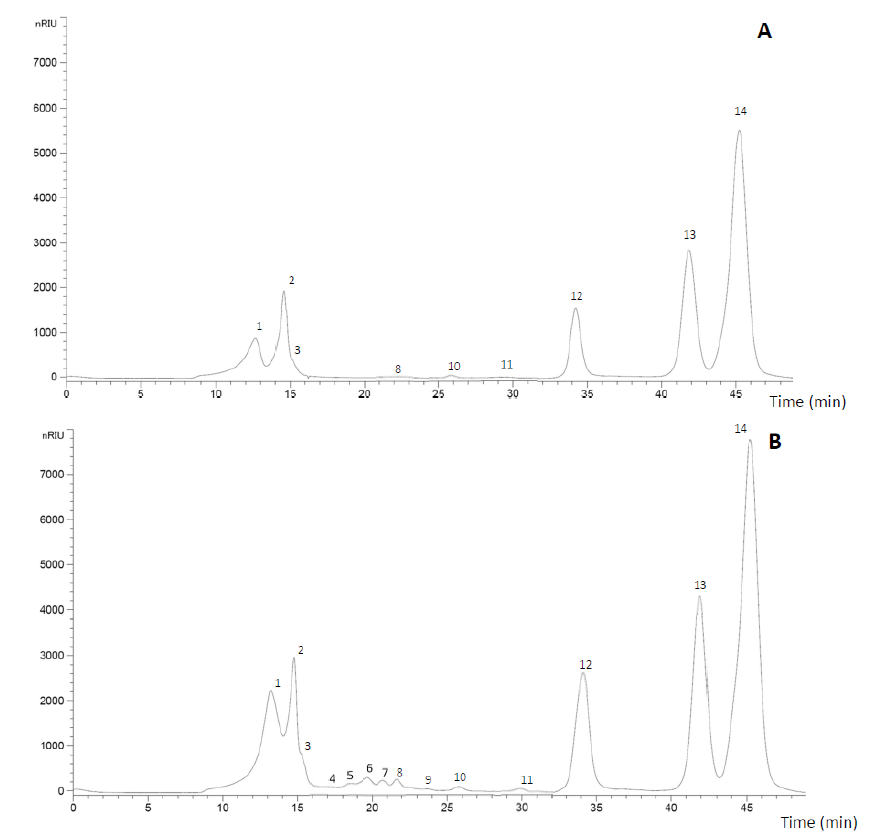
Figure 3. HPLC-RID chromatograms of apple by-product: ( A ) control and ( B ) samples treated with HHP (200 MPa) for 15 min assisted by Celluclast ® (92 EGU). Peaks 1–5 were estimated as polysaccharides or high molecular weight carbohydrates (HMWC). Peaks 6–14 were estimated as oligosaccharides and simple sugars or low molecular weight carbohydrates (LMWC).